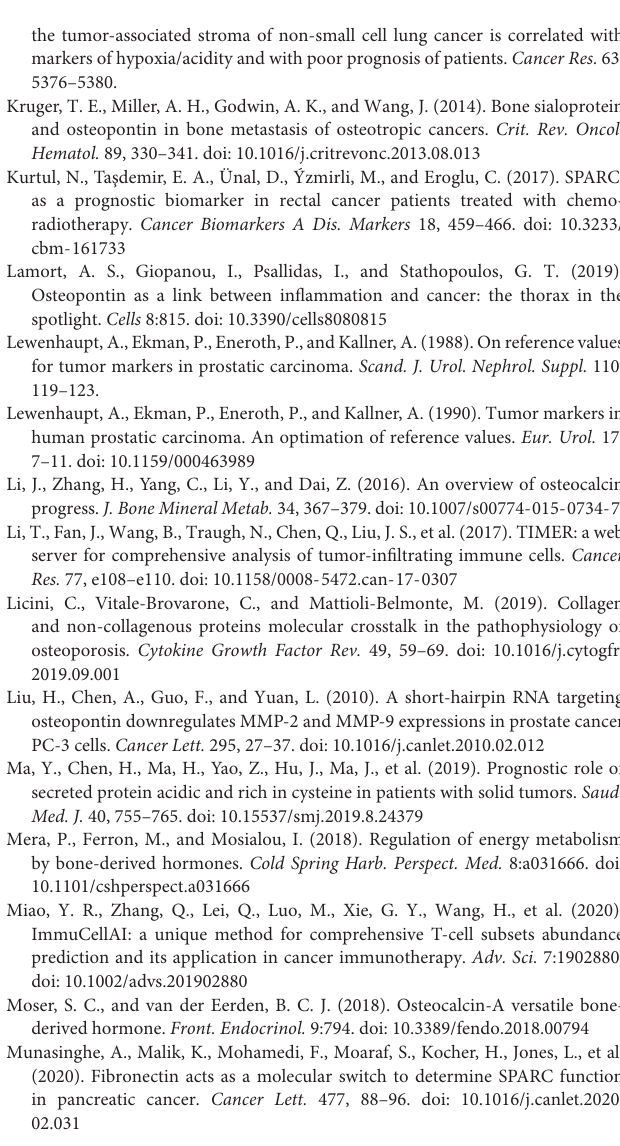
Supplementary Figure 1 | Kaplan-Meier plots of overall survival in different SPARC/SPP1/BGLAP subgroups in the cancer types in which they acquired no prognostic value. (A) BLCA, (B) BRCA, (C) ESCA, (D) LUSC, (E) PAAD, (F) PRAD, (G) READ, (H) SKCM, (I) STAD, (J) THCA, (K) THYM, (L) UCEC. p < 0.05 represents significant difference in survival